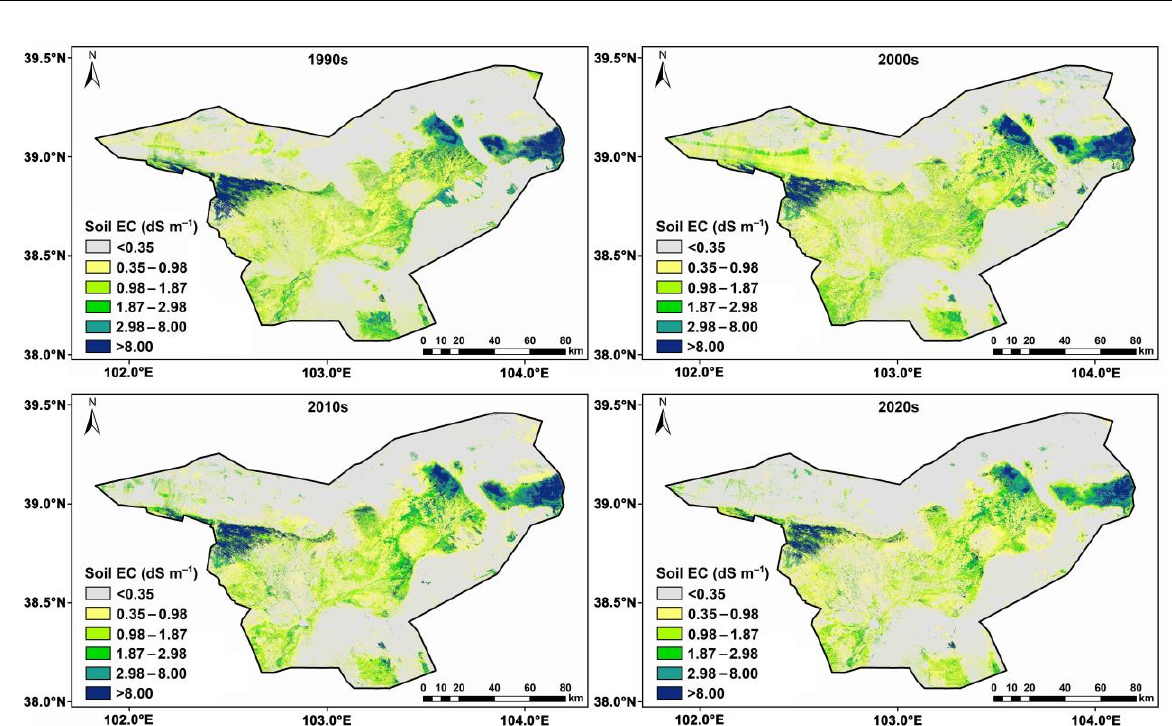
Figure 6. Spatial patterns of soil EC at 0 − 20 cm estimated based on 30 runs of the XGBoost models for the 1990s, 2000s, 2010s, and 2020s. Note: soil EC was mapped at a resolution of 30 m.